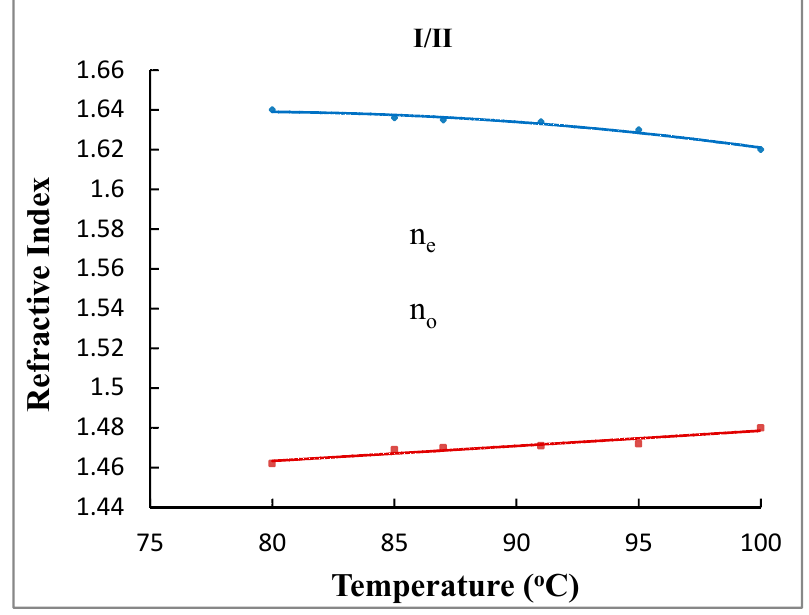
Figure 8. Dependence temperature of refractive indices ( (cid:4) ) n o and ( (cid:7) ) n e for the complex I / II at 543 nm.